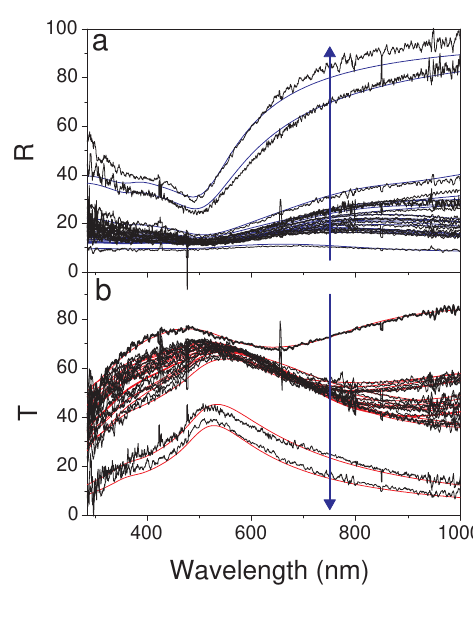
Figure 2. Reflectance (a) and Transmittance (b) of the whole set of samples. Black: experimental data. Color: simulation. The arrows indicate the direction of increasing overall deposited